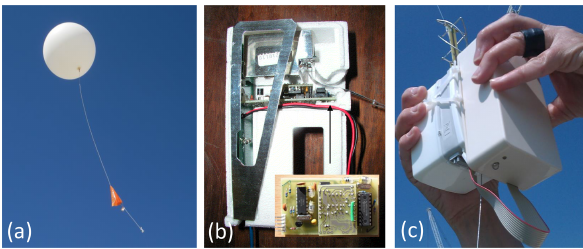
Figure 6. (a) Radiosonde in flight, showing the carrier balloon and parachute for the descent. (b) RS80 radiosonde partially disassem- bled, showing the data acquisition system (RS80DAS) mounted within an internal cavity. (Inset photograph shows the RS80DAS circuit board.) (c) PANDORA system fixed to a RS92 radiosonde immediately pre-launch, showing the ribbon cable data connection to the radiosonde ozone interface